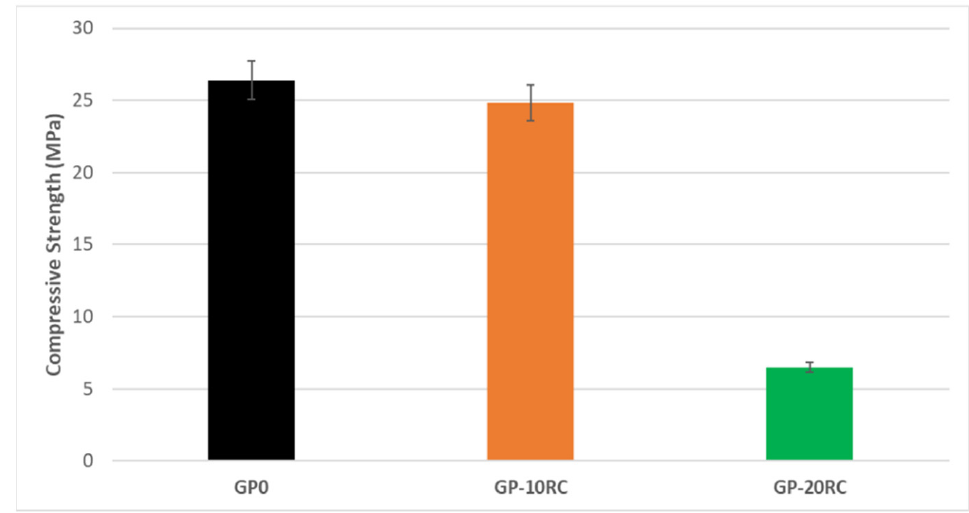
Figure 6. Compressive Strength for all the samples after 28 d.